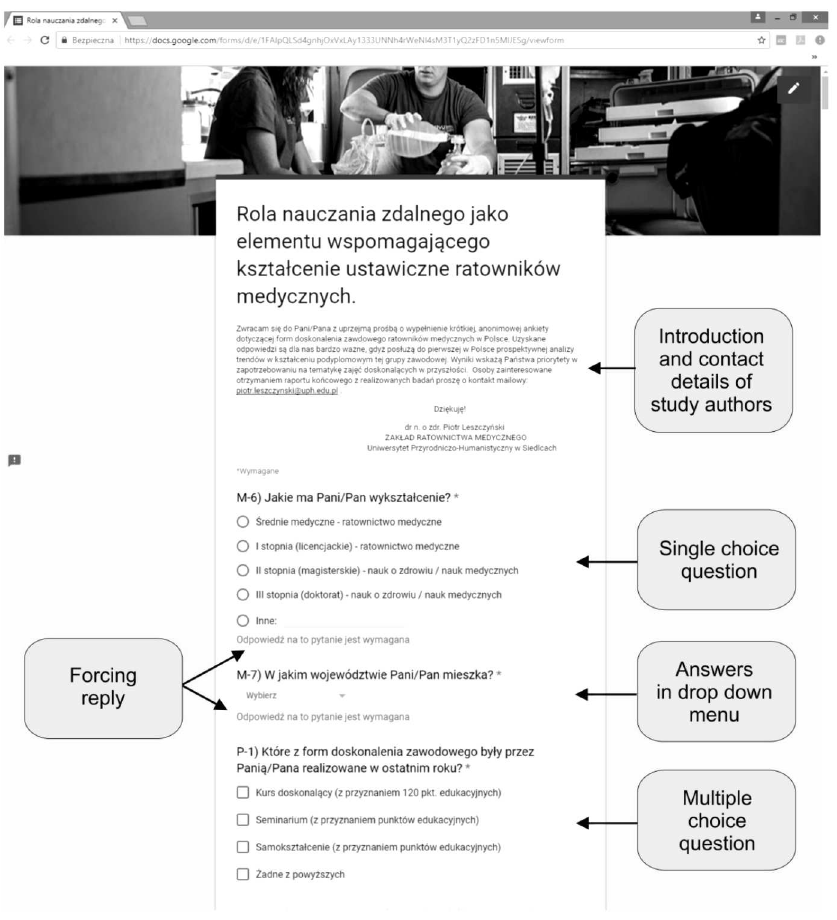
Figure 1. Functionalities of the own online